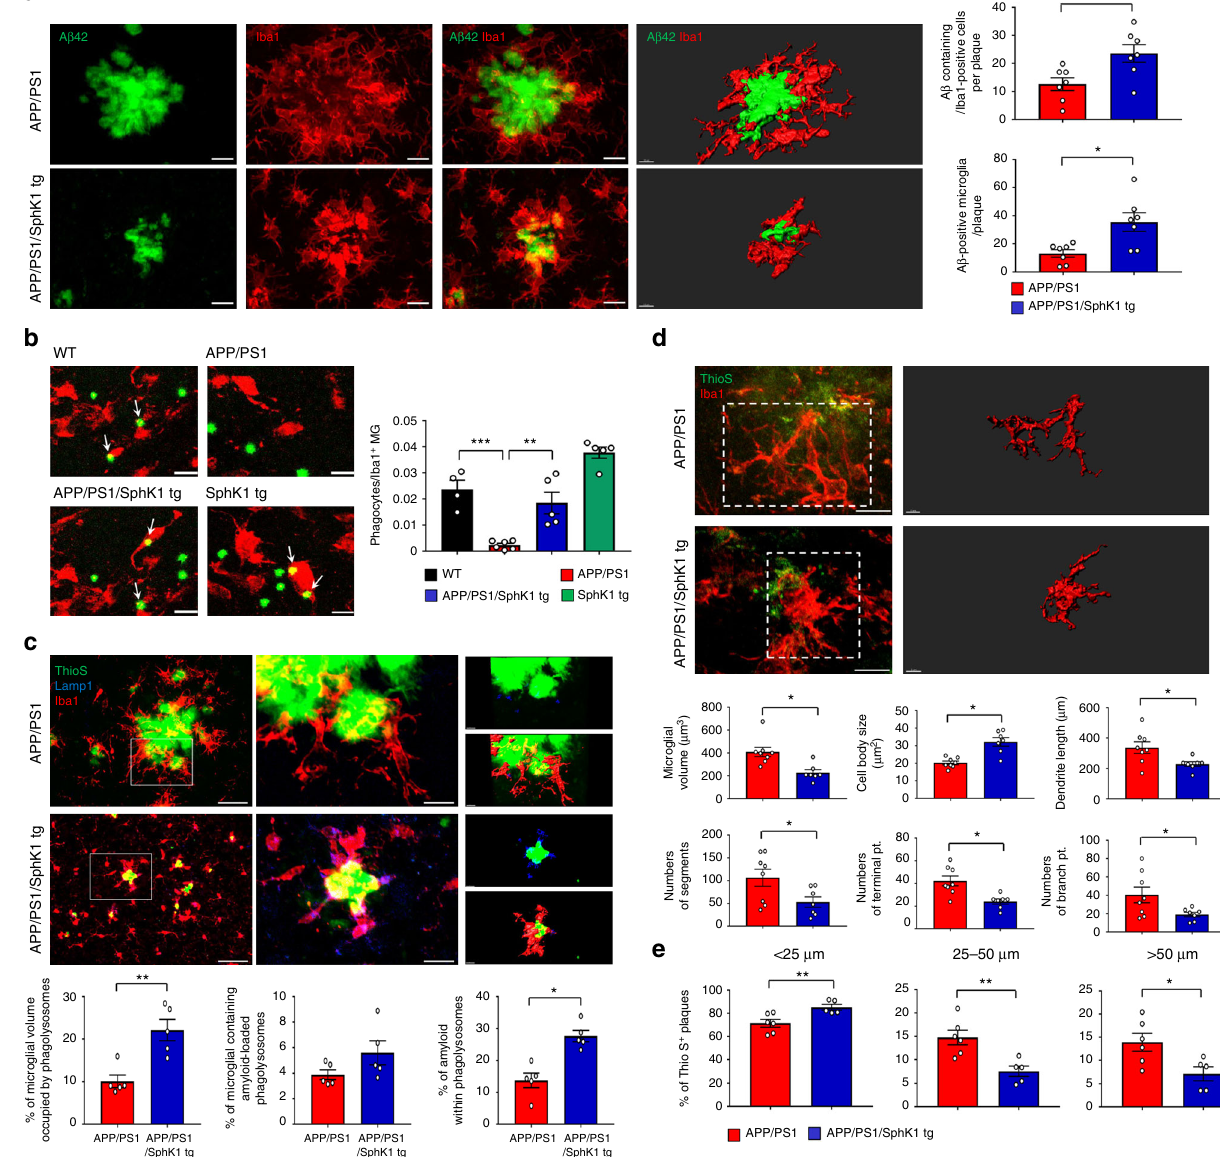
Fig. 5 Increased SphK1 improves microglial phagocytosis. a Colocalization of microglia (Iba1, red) with A β (A β 42, green) and quanti fi cation. Scale bars, 10 μ m; 3D reconstruction from confocal image stacks scale bars, 10 μ m ( n = 7 per group). b Left, representative photomicrograph of live slice section incubated with fl uorescent beads (green). Scale bar, 10 μ m. White arrow point to phagocytotic microglia with fl uorescent beads. Right, quanti fi cation of the number of microglial phagocytes normalized to the total number of microglia ( n = 4 – 6 per group). c Up, immuno fl uorescence images of thio S (A β plaques, green) encapsulated within Lamp1 + structures (phagolysosomes, blue) in microglia (Iba1, red) present in brains of APP/PS1 and APP/PS1/SphK1 tg mice. Low-magni fi cation scale bars, 50 μ m; High-magni fi cation scale bars, 10 μ m; 3D reconstruction from confocal image stacks scale bars, 10 μ m. Down, quantitation of microglial volume occupied by Lamp1 + phagolysosomes, percent of microglia containing A β -loaded phagolysosomes and A β encapsulated in phagolysosomes ( n = 5 per group). d Morphology of microglia (Iba1, red) surrounding A β (ThioS, green) in cortex of APP/PS1 and APP/PS1/SphK1 tg mice. Up, high magni fi cation (Scale bars, 10 μ m) and Imaris-based three-dimensional images (Scale bars, 5 μ m) of microglia surrounding A β . Down, Imaris- based automated quanti fi cation of microglial morphology ( n = 7 – 8 per group). e Morphometric analysis of A β plaques in APP/PS1 and APP/PS1/SphK1 tg mice ( n = 5 – 6 per group). Brain sections were labeled with thio S and plaques were counted and assigned to three mutually exclusive size categories based on maximum diameter: small <25 μ m; medium 25 – 50 μ m; or large >50 μ m. All data analysis was performed on 9-month-old mice. a , c − e , Student ’ s t test. b One-way analysis of variance, Tukey ’ s post hoc test. * P < 0.05, ** P < 0.01, *** P < 0.001. All error bars indicate